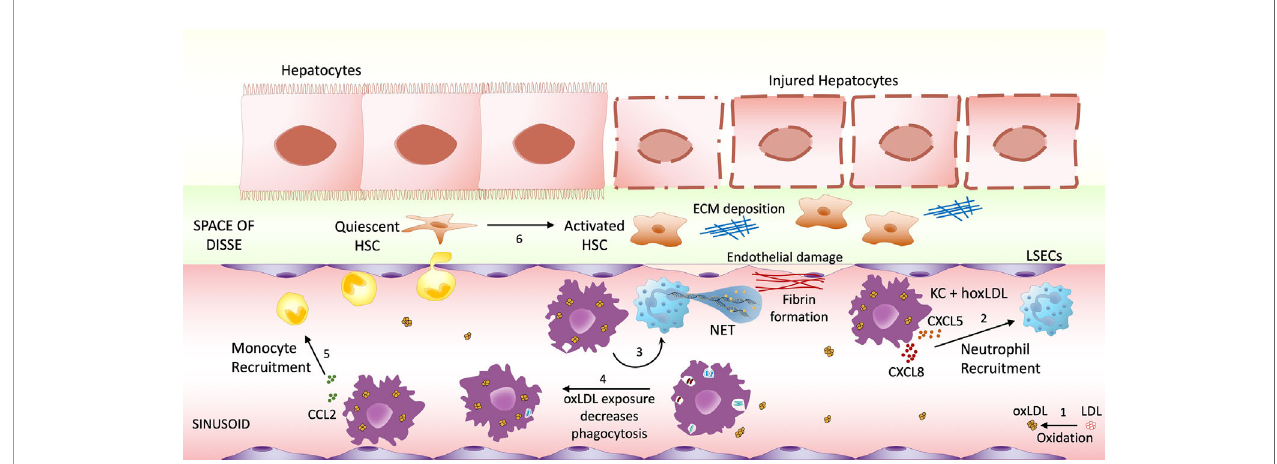
FIGURE 6 | Highly oxidized LDL potential impact on NASH progression. (1) Low-density lipoprotein (LDL) can undergo oxidative modi fi cation. The increase of circulating oxLDL affects both in fi ltrating macrophages and sinusoid resident Kupffer cells. Once stimulated by LDL oxidized in high degrees, macrophages/KCs change their phenotype to M4-like proin fl ammatory phenotype, increasing the recruitment of neutrophils (2) and inducing NET formation (3), which will cause endothelial damage. M4 macrophages also decrease their phagocytic activity (4), possibly allowing the accumulation of endotoxin and microorganism. Another feature of these M4-like macrophages is the increased CCL2 production, possibly recruiting more monocytes to the in fl ammatory site (5). The combination of these events may contribute to Hepatic Stellate Cells (HSC) activation (6), resulting in hepatocyte injury and fi brosis